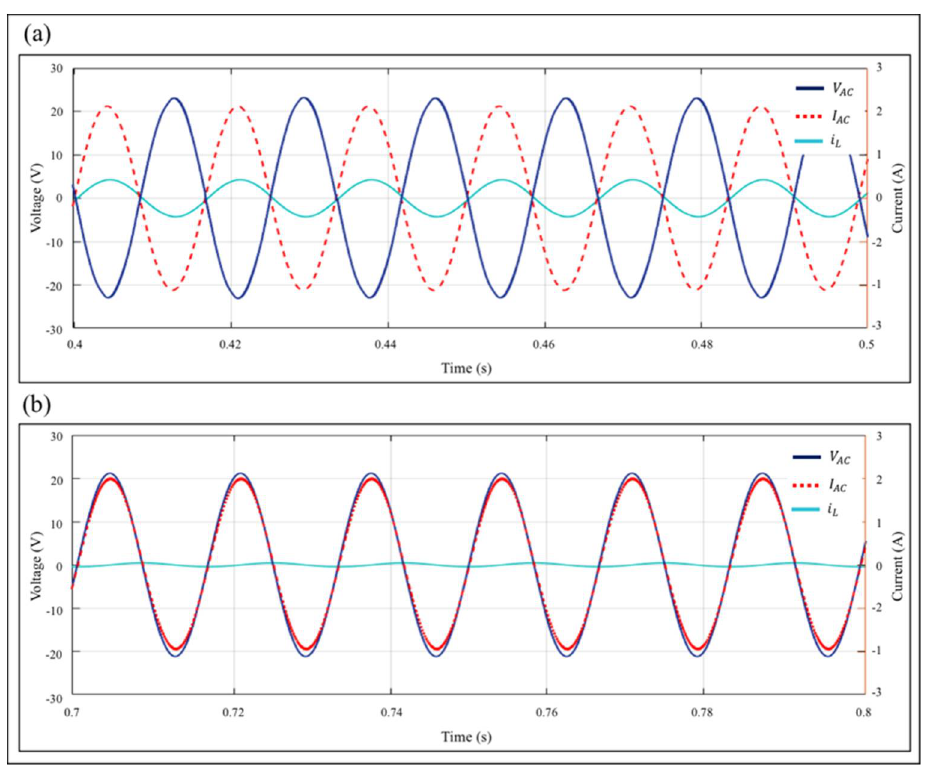
Figure 8. The stable response, ( a ) with power generation of PV array; ( b ) without power generation of PV array.